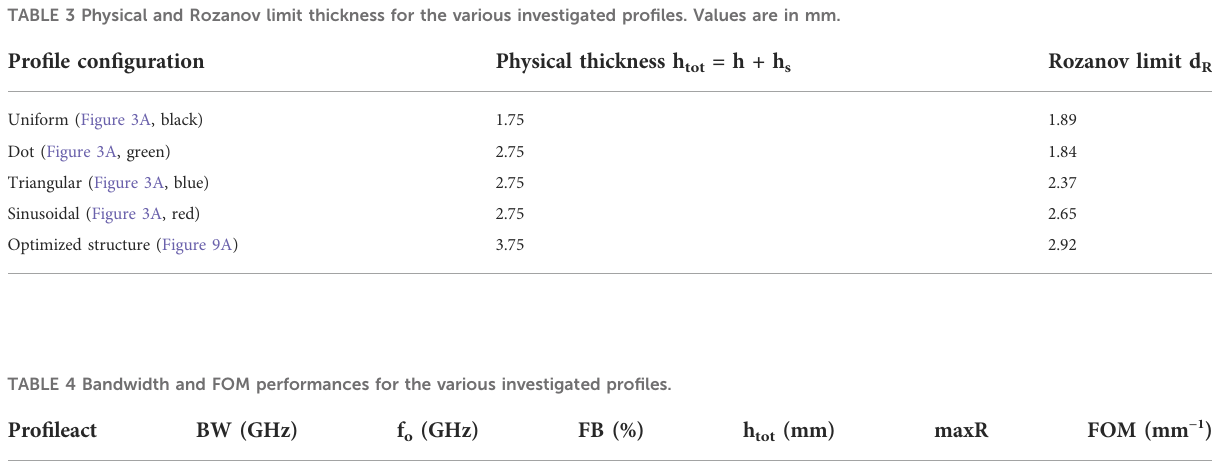
TABLE 3 Physical and Rozanov limit thickness for the various investigated pro fi les. Values are in mm.